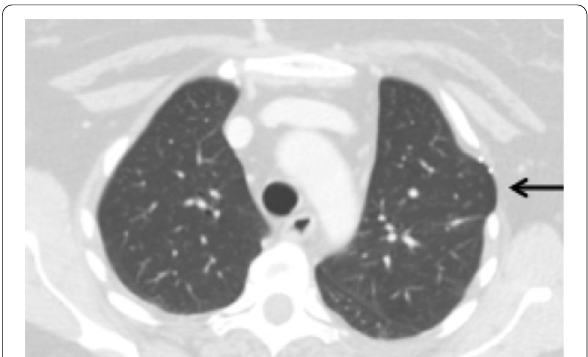
Fig. 17 Parietal dehiscence. Left upper lobe parenchyma herniation (black